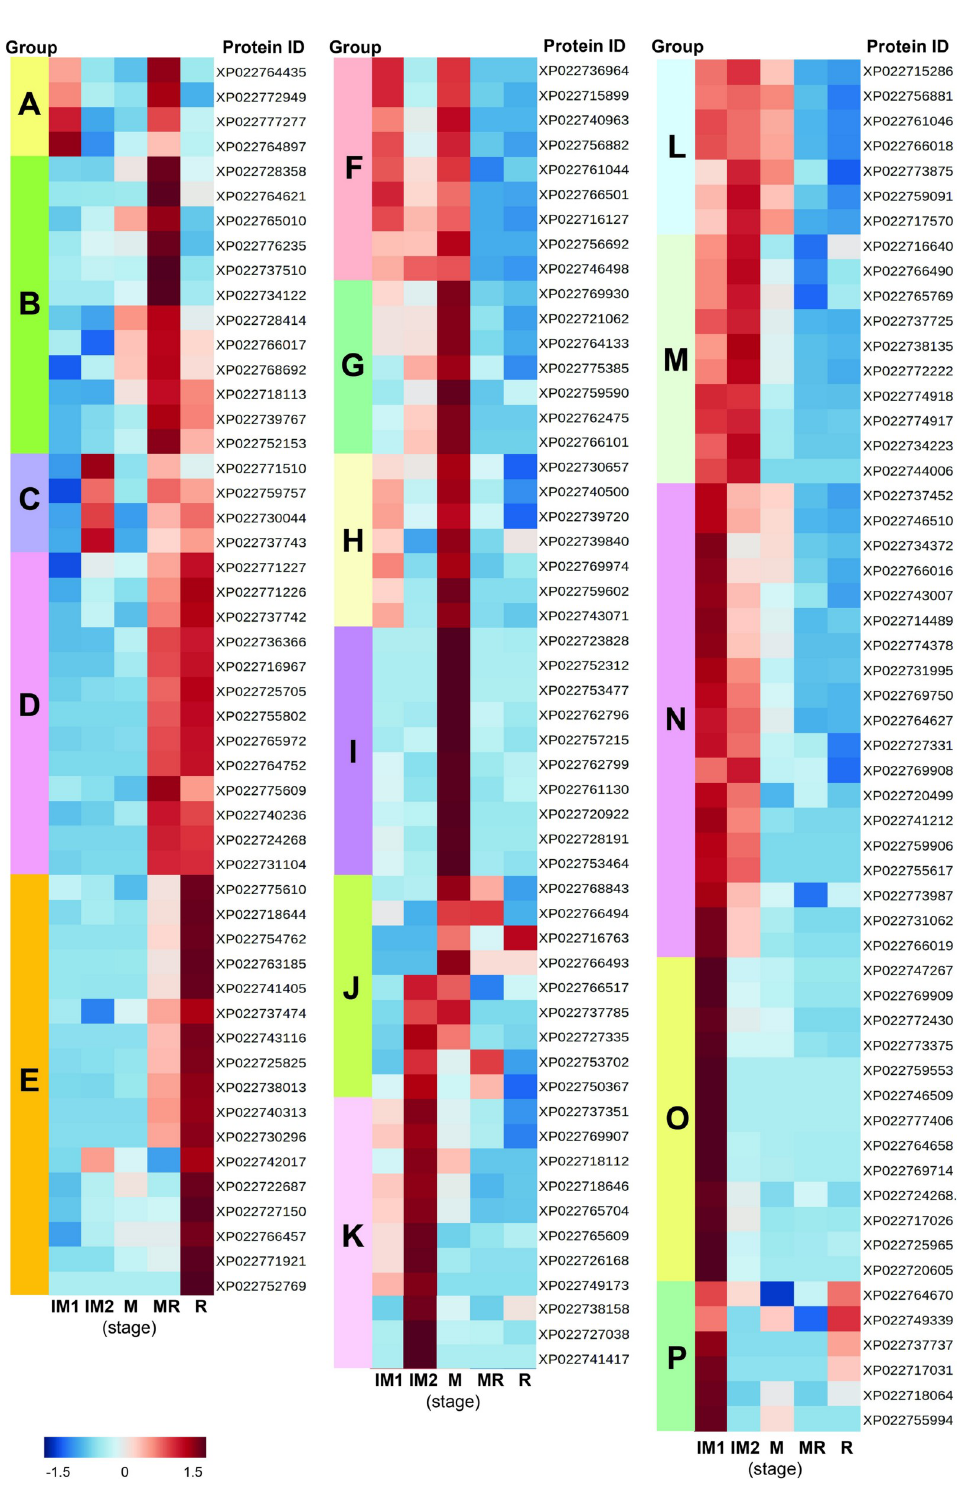
Fig 3. RNA-seq based expression profile of durian P450s during the five stages of the Monthong cultivar. The P450s were grouped as groups A–P based on a ward clustering algorithm using MetaboAnalyst 5.0, an open-source R-based program. Data were sum normalized, log-transformed, and auto scaled. The color scale indicates the z-score. Stage abbreviations: IM1, immature1; IM2, immature2; M, mature; MR, mid-ripe; R, ripe.